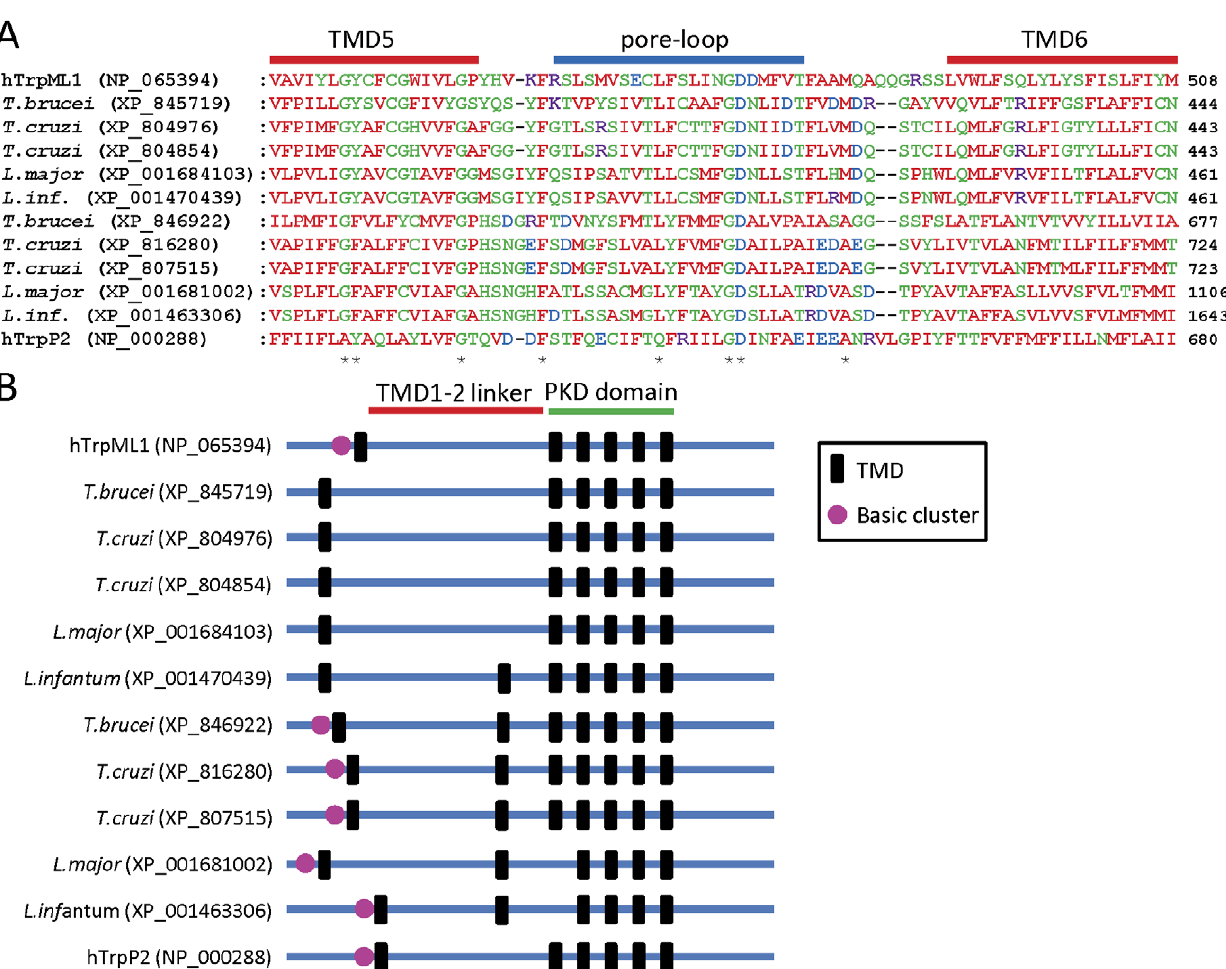
Figure 4. Trp channel homologues in kinetoplastid parasites. (A) Alignment of the pore regions of human TrpML and TrpP2 channel subunits with putative homologues from kinetoplastid parasites. Sequences of the putative pore loops as well as part of the TMD5 and TMD6 regions are shown. Numbers in parentheses to the right of the alignments indicate the total number of residues in the protein. Asterisks below the alignment indicate residues that are absolutely conserved between parasite proteins and either hTrpML1 or hTrpP2. L. infantum is shown abbreviated to L. inf. (B) Schematic showing the location of predicted TMDs (black bars) within the full-length sequences of human TrpML1 and TrpP2 channel subunits, as well as parasite homologues. The conserved PKD polycystin domain (pfam08016; identified using the Conserved Domains Database, NCBI) is indicated, as well as the long TMD1-TMD2 linker characteristic of mammalian TrpML and TrpP2 channel subunits. The presence of an N-terminal cluster of basic residues preceding TMD1 is indicated by a purple